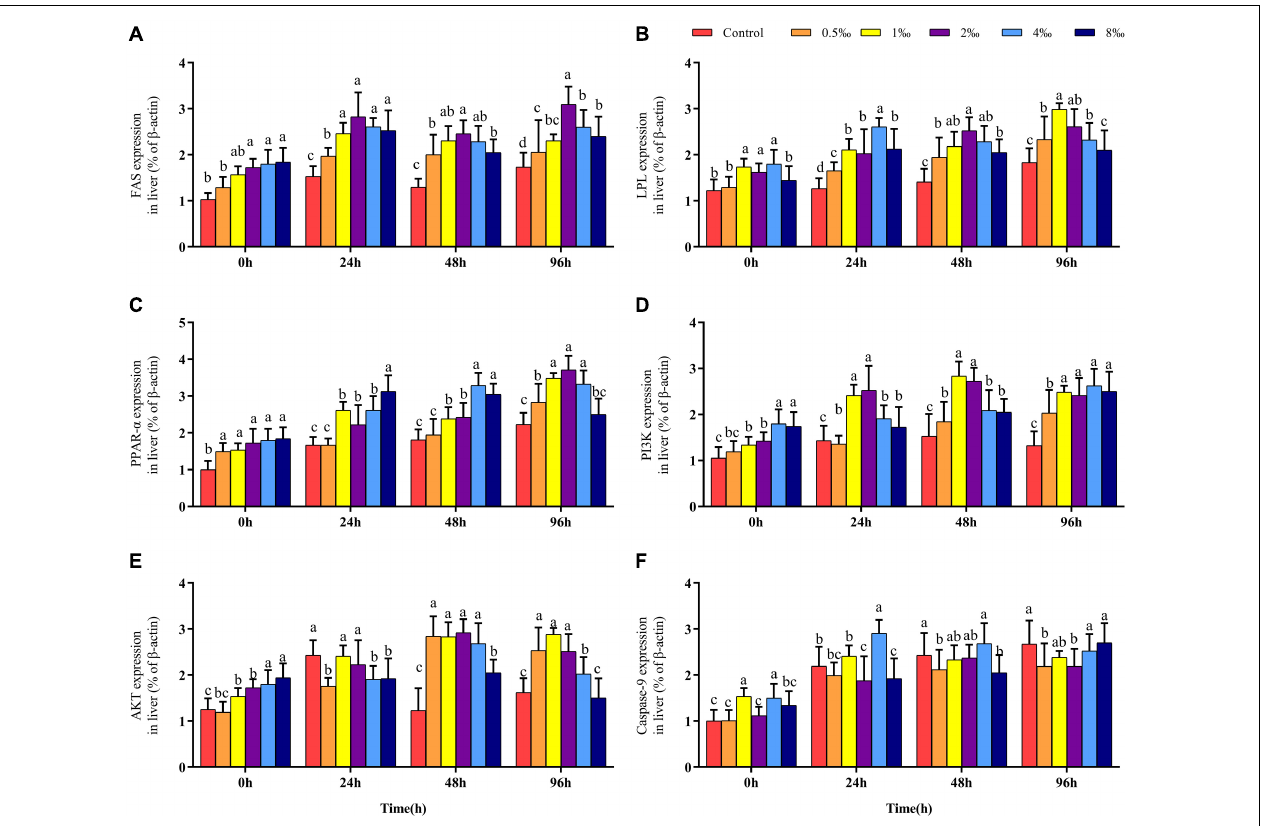
FIGURE 4 | Fatty acid metabolism and PI3K/AKT pathway of GIFT infected with S. iniae after being fed different APS levels. (A–F) Represent the control, 0.5, 1, 2, 4, and 8 APS supplementation treatments, respectively. Different lowercase letters show significant differences among different treatments at each sampling point (Duncan’s multiple range test; P < 0.05). (cid:104)